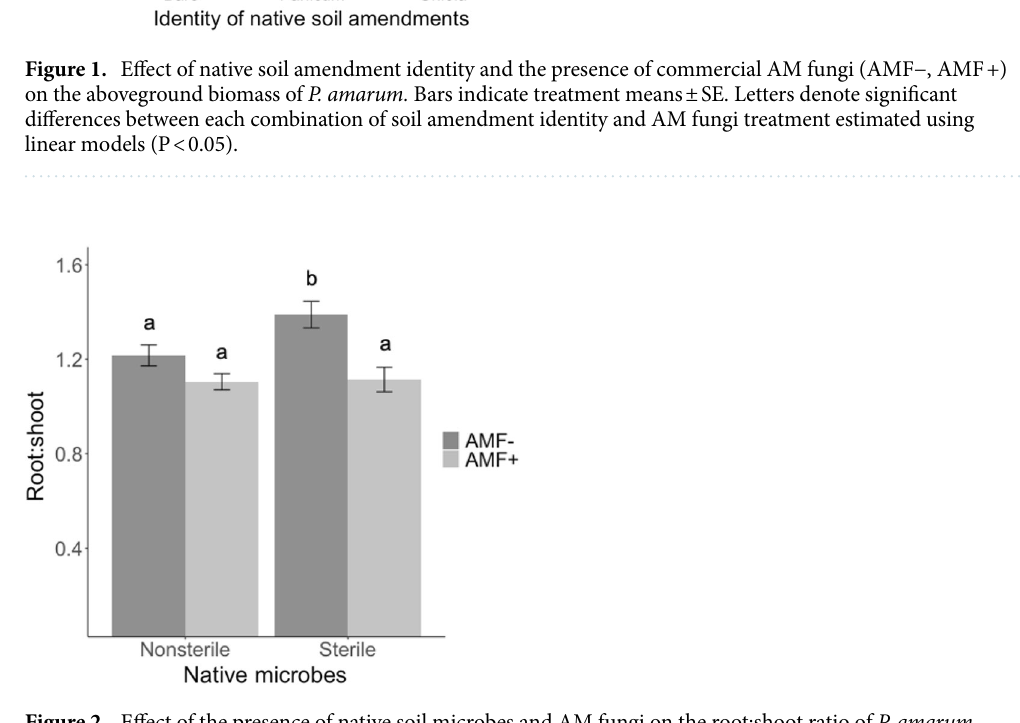
Figure 2. Effect of the presence of native soil microbes and AM fungi on the root:shoot ratio of P. amarum . Bars indicate treatment means ± SE. Letters denote significant differences between each combination of presence of native soil microbes and AM fungi treatment estimated using linear models (P <